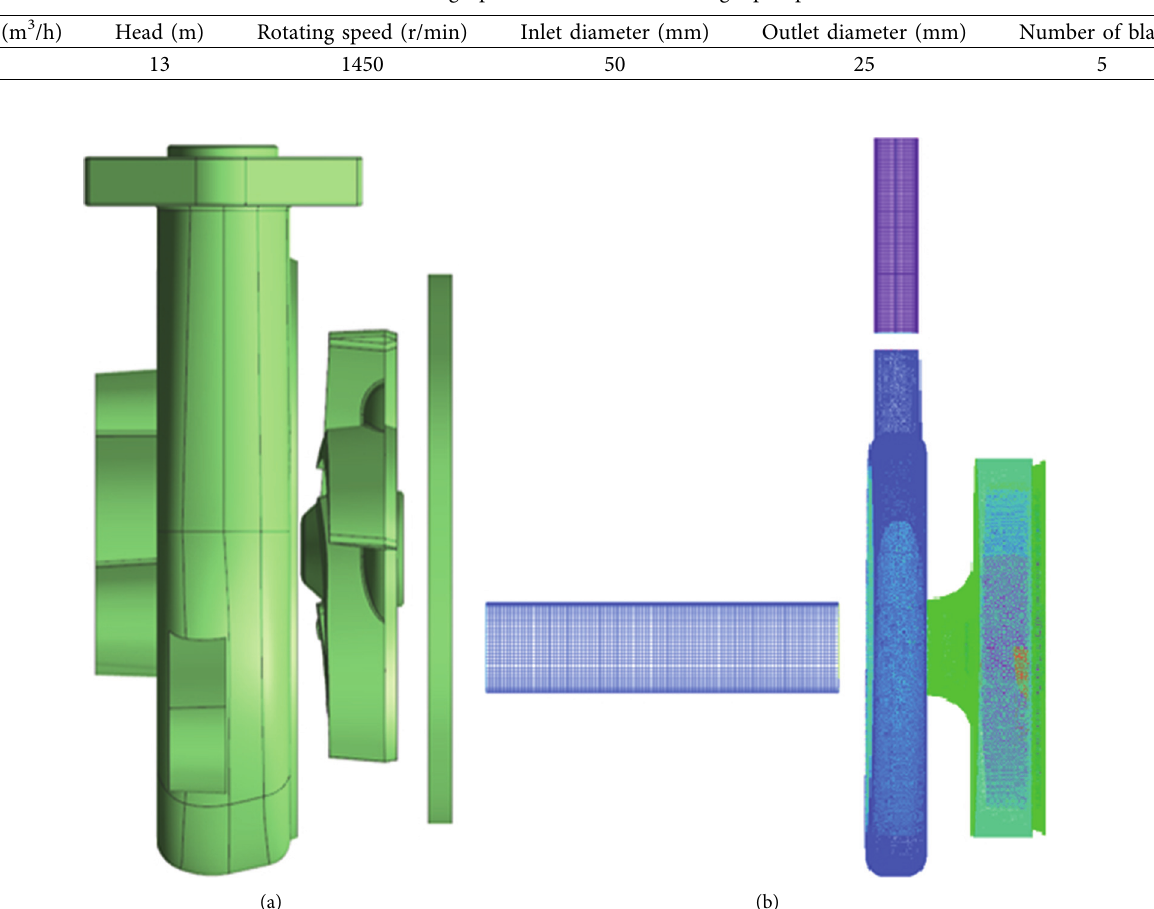
Table 1: Design parameters of the centrifugal pump.